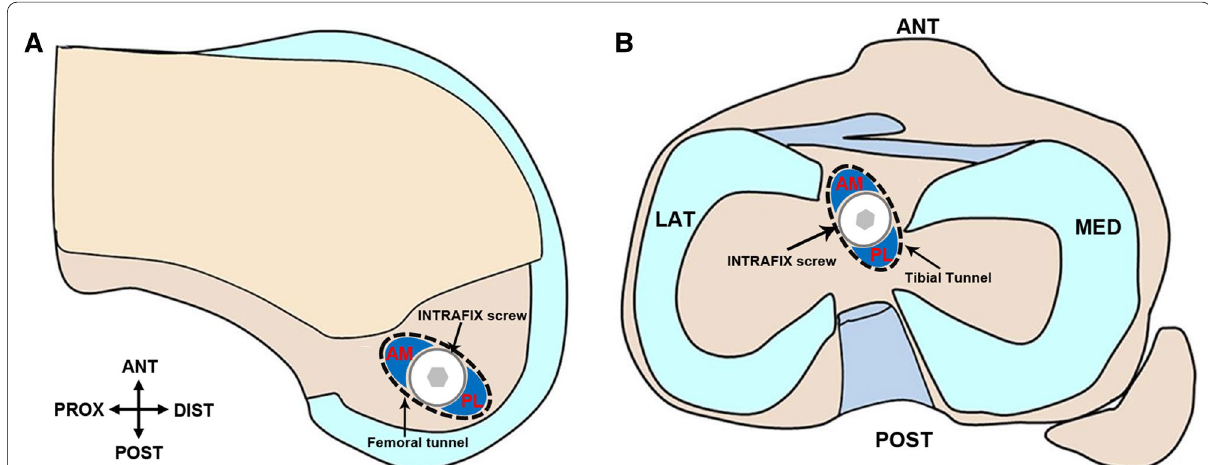
Table 1 General information on the patients